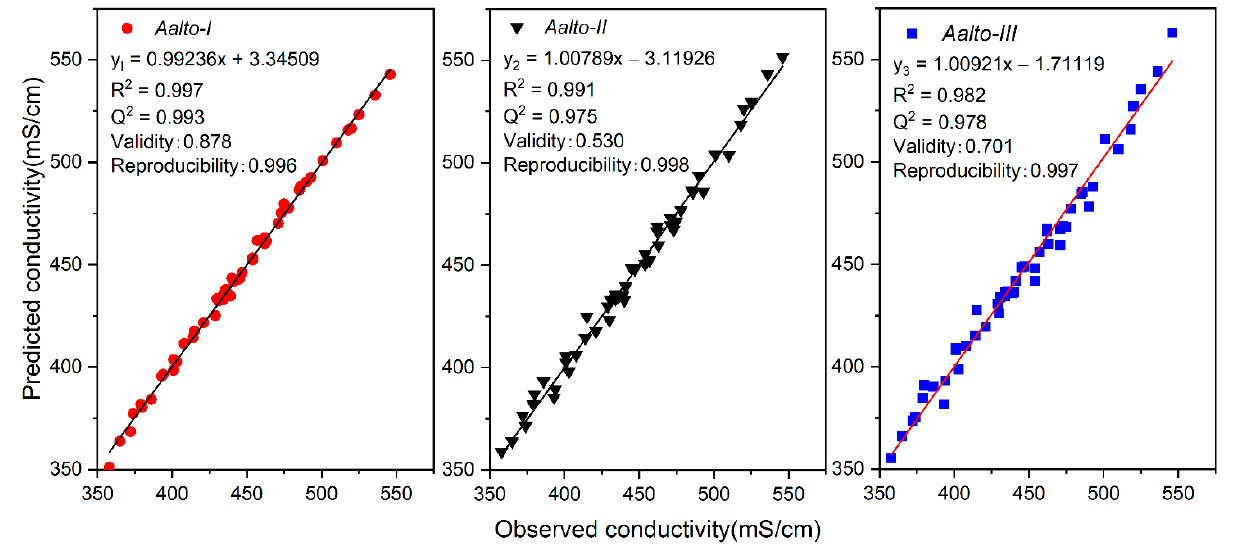
Figure 4. Measured (synthetic Zn electrolyte) vs. predicted conductivity by models Aalto-I, II and III .